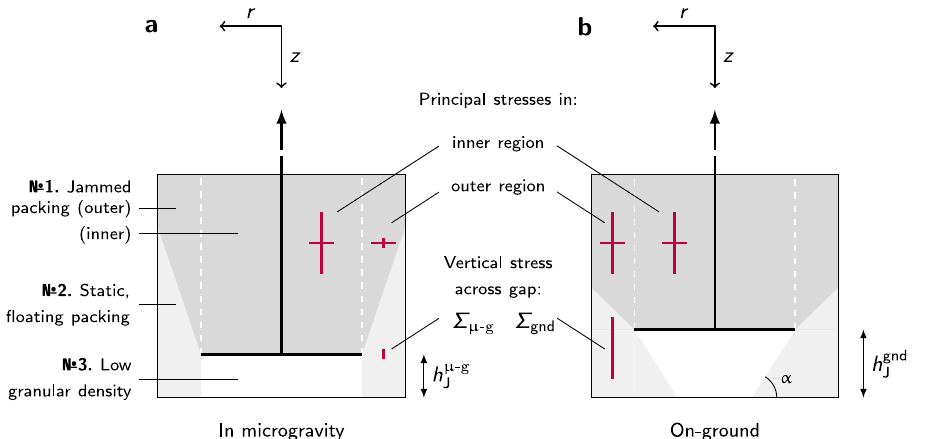
Fig. 7 Schematic representation of the regions appearing in the container as the piston rises. a in microgravity ( μ -g) and b on-ground (gnd). On-ground, the powder forms a slope at its angle of repose α with the horizontal. Stress magnitudes in arbitrary units are depicted by red lines. The coordinate system used in the body of the text is shown above each schematic. The height h μ (cid:1) g ; gnd the piston is stopped by the jammed material above it, respectively under microgravity and on-ground conditions. The difference in force chain con fi guration between microgravity and ground leads to drastically different vertical stresses in the outer region. The load Σ on the material below the piston is, as a consequence, much lower in microgravity compared to the ground. See also Supplementary Material, Supplementary Figure